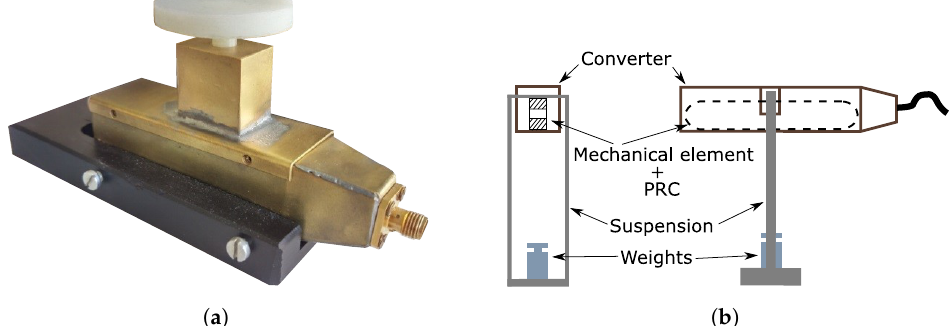
Figure 5. Loading structure with TEMcell ( a ). Suspended version of loading structure with TEMcell ( b